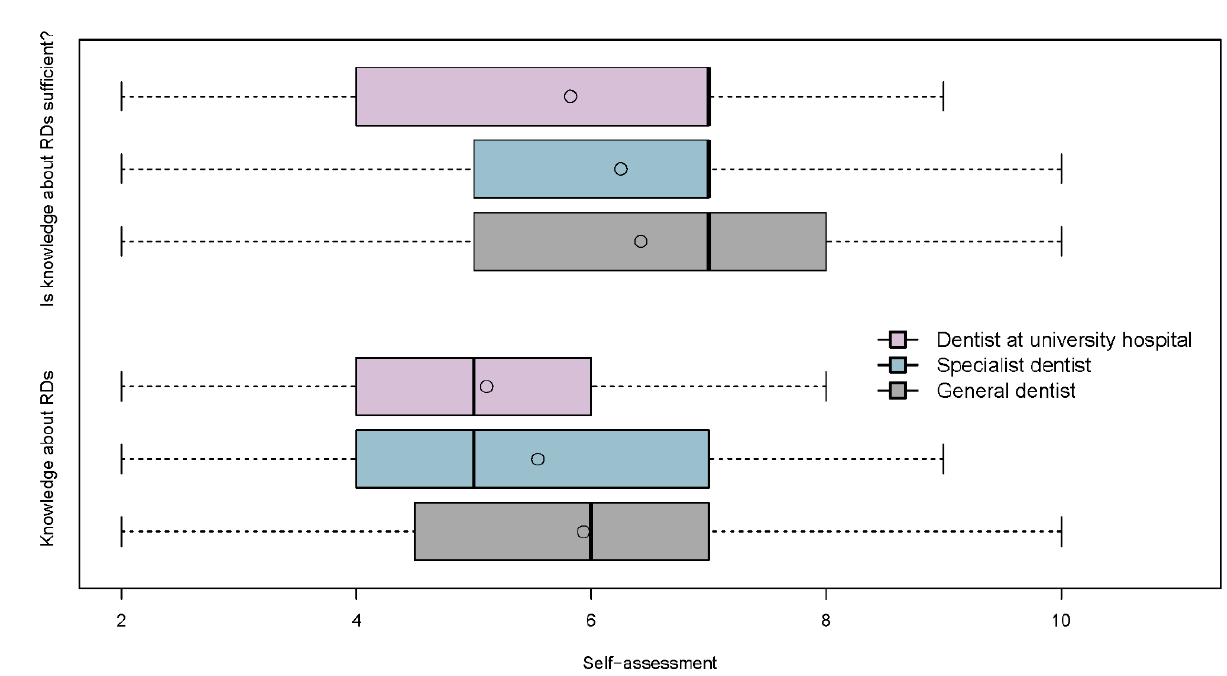
Figure 3. Self-assessment of knowledge about rare diseases (RDs) and self-assessment whether their own knowledge about RDs is sufficient. Evaluated on a scale with direction from positive (left) to negative (right) being 1 = very good knowledge/yes, knowledge is sufficient and 10 = inadequate knowledge/knowledge is not sufficient at all. Participants could only see the labels of the limits 1 and 10. Differences between the groups of dentists were tested via two-sided Kruskal–Wallis tests and adjusted using the Bonferroni method. For both self-assessments, no significant differences between the professional groups were observed (adjusted p -value > 0.05).